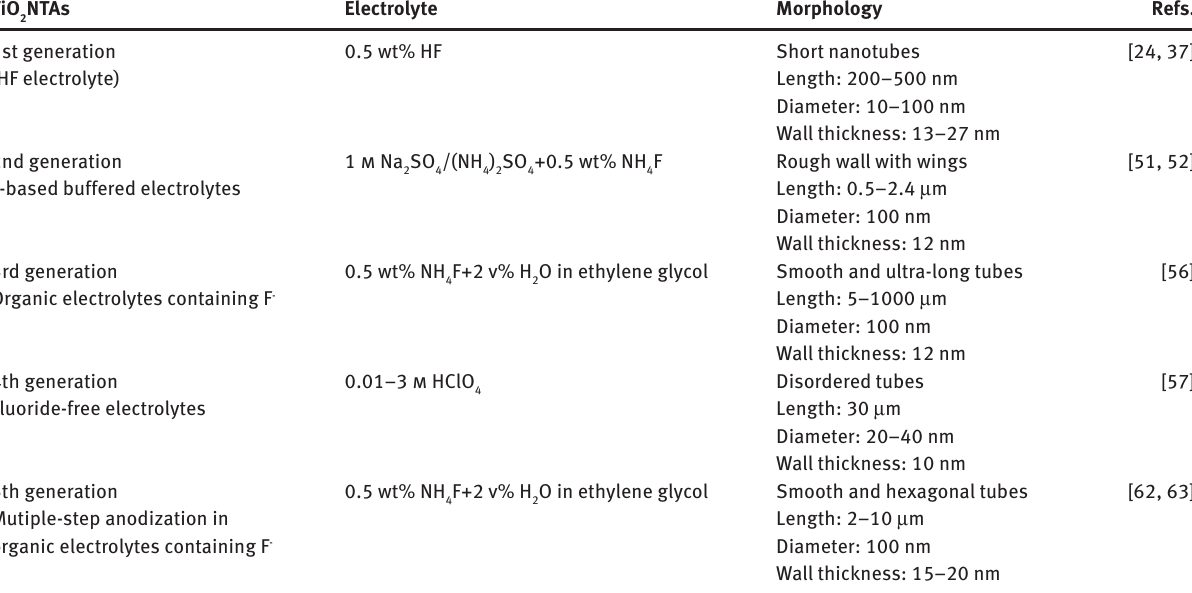
Table 1: Brief summary of various synthesis generations of TiO TiO 2